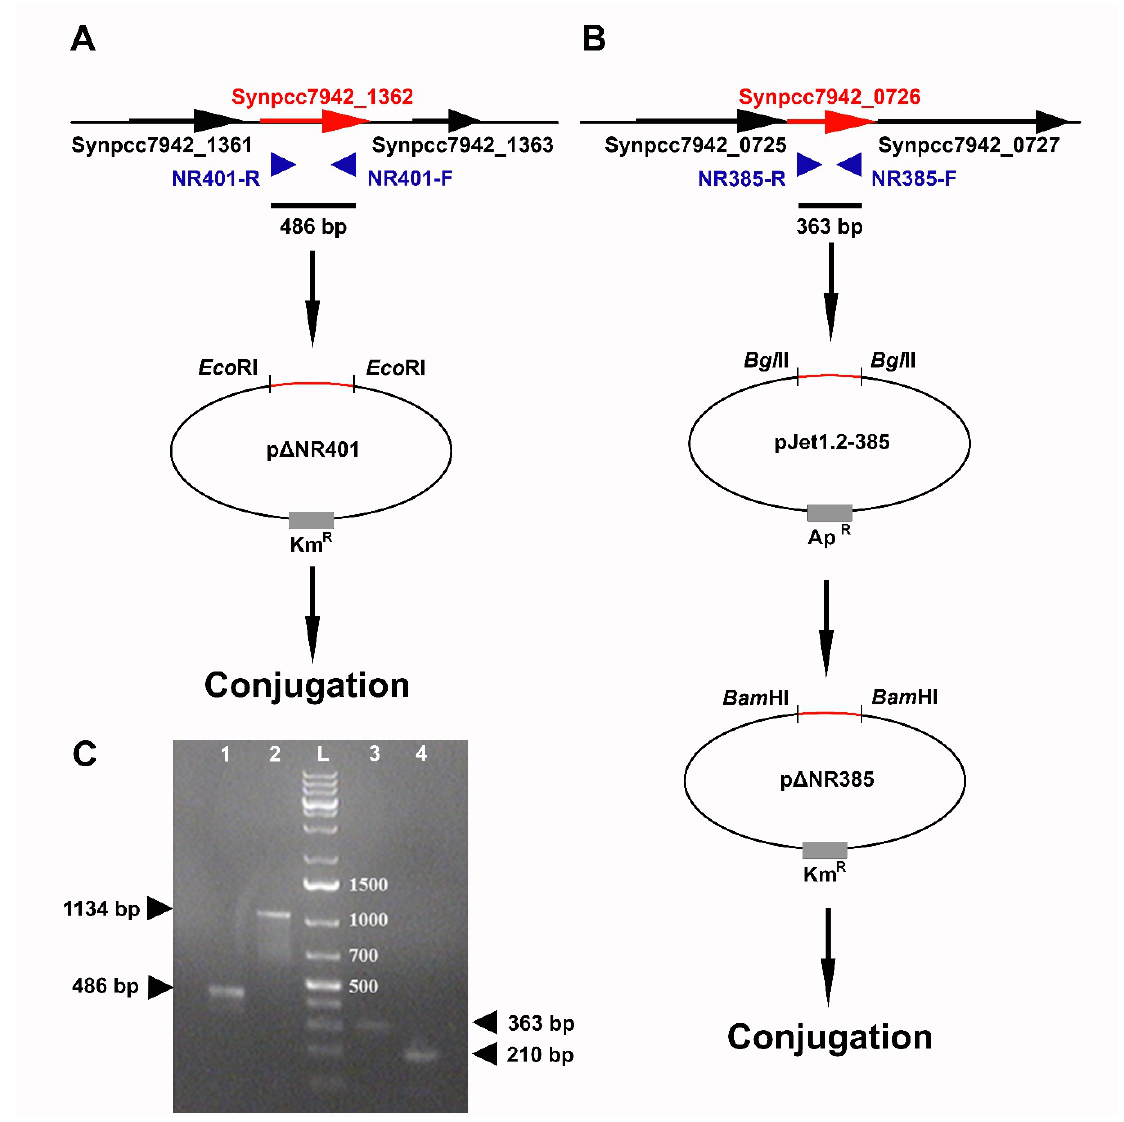
Figure 1. This scheme represents the genetic constructions that have been made by using the deleted copies of the target genes for site-directed mutagenesis of Synechococcus wild type cells. ( A ) Construction of a plasmid p ∆ NR401. Deleted copy of the Synpcc7942_1362 gene was amplified and cloned into the pRL498 vector in Eco RI sites. Blue arrows correspond to primers. ( B ) Construction of a plasmid p ∆ NR385. Deleted copy of Synpcc7942_0726 gene was amplified and cloned into pJet1.2 / blunt vector. The fragment was digested in Bgl II / Bam HI sites and cloned into pRL498 for further conjunction. Blue arrows correspond to primers. ( C ) Gel electrophoresis of the PCR products of the target genes. Lanes: 1 Synpcc7942_1362 (for ∆ NR401), 2 Synpcc7942_0351 (for ∆ NR365), 3 Synpcc7942_0726 (for ∆ NR385), and 4 Synpcc7942_0732 (for ∆ NR359), L -GeneRuler 1 kb Plus DNA